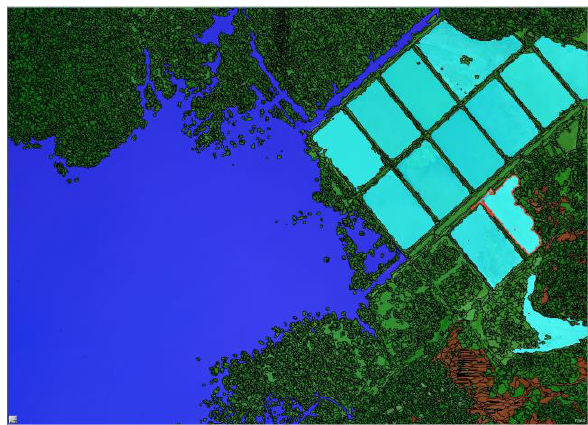
Figure 11d. Image showing extracting the aquaculture ponds.